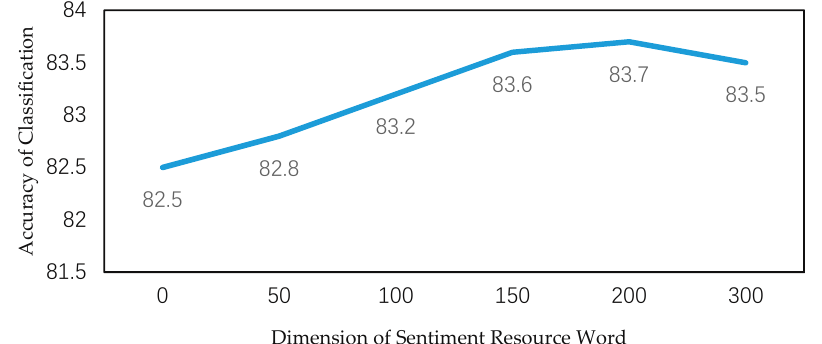
Figure 4. Classification of different dimensions of sentiment resource words on the MR dataset. When the dimension of the word vector is equal to 0, it means that the sentiment attention mechanism was not used in this model.